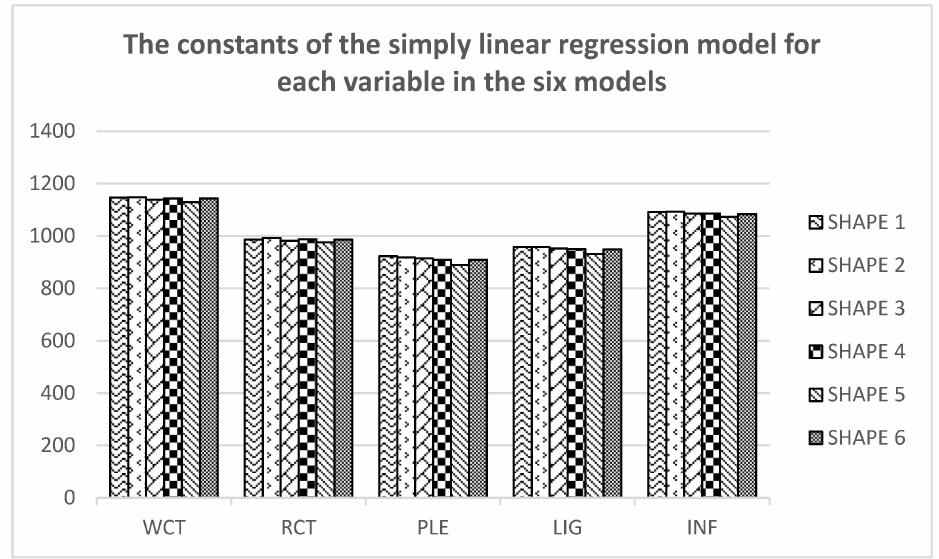
Figure 18. Constants plot of variables for 6